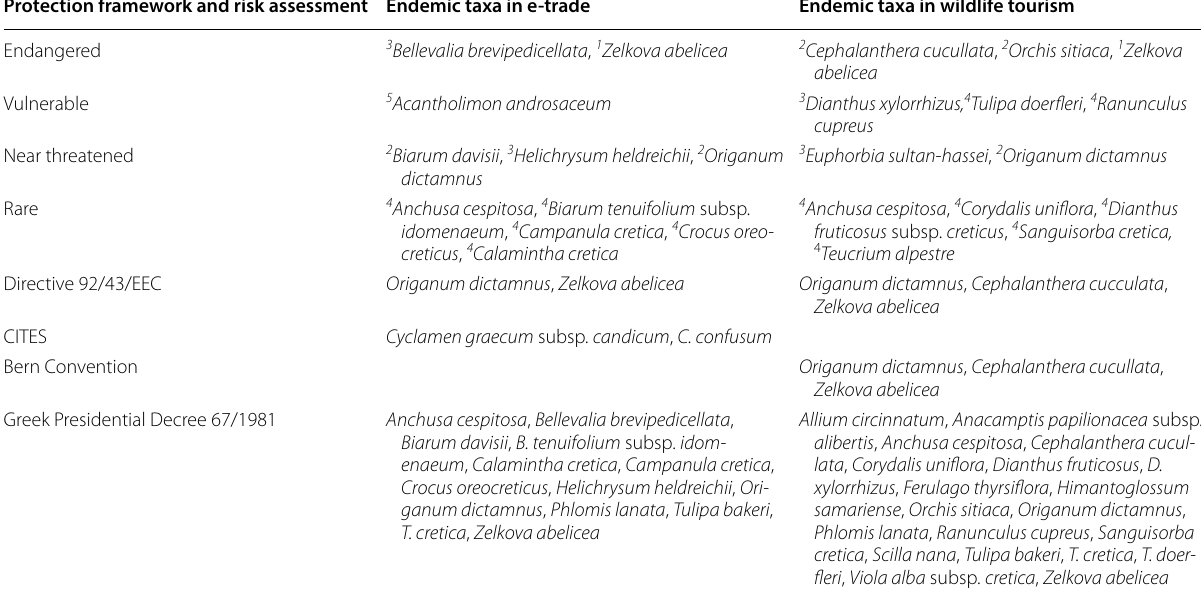
Table 4 Cretan endemics involved in the e-trade and wildlife tourism that are protected under different frameworks and/ or face extinction